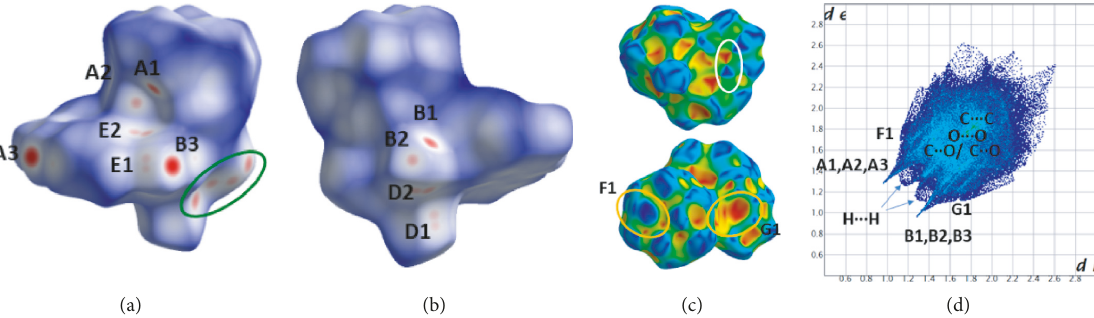
Figure 4: (a), (b) Different views of the dnorm decorated HS, (c) two views of the shape decorated HS, and (d) fingerprint plot for the 1b complex. A1, A2, A3 and B1, B2, B3 are the donor and acceptor contact points of C 18 -H 18 (A) · ·· O 2 , C 14 -H 14 (B) ··· O 2 , C 9 -H 9 ·· · O 5 hydrogen bond interactions. The green ellipse in (a) indicates the area of antiparallel CO · ·· CO, C 3 ≡ O 3 carbonyl interactions. E1, E2 and D1, D2 are the donor and acceptor contact points involved in the M-C ··· CO, O 5 · · · C1 ‴ type of interactions. The white and orange ellipses in (c) indicate π · ·· π and C-H ··· π (F1 and G1 are donor and acceptor contact points, respectively, Table 5) type of